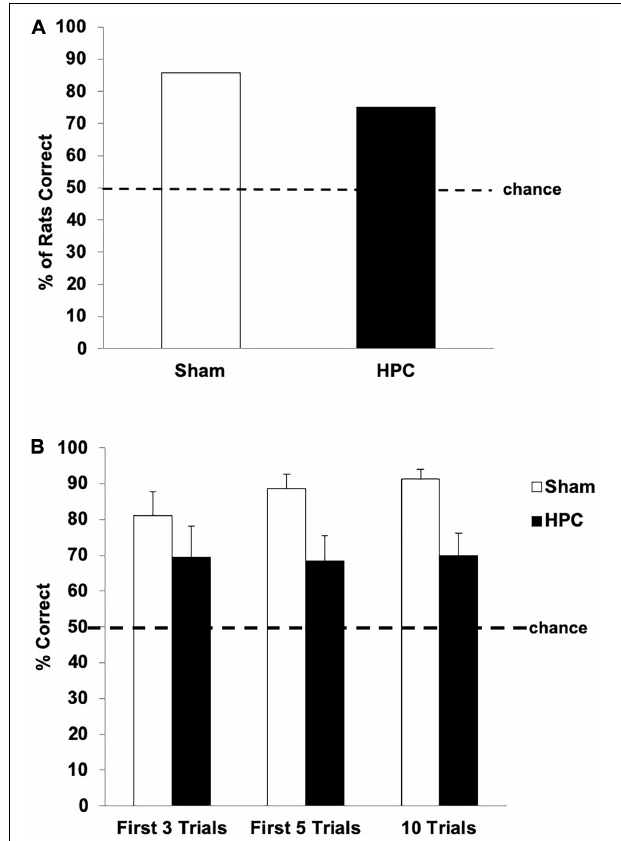
FIGURE 5 | Post-surgical retention performance of the Sham and HPC rats that received 230 overtraining trials following the visual discrimination criterion learning. (A) Percent of rats in each group choosing S+ on the first retention trial. Although both groups tended to show a preference in swimming to the S+, the bias was not statistically significant for either group ( p > 0.05). (B) Mean ( ± SEM) percent of correct trials on the first three trials, first five trials, and all 10 retention trials. Both Sham and HPC rats, regardless of the number of trials considered, showed a an S+ selection statically above chance (50%, ps < 0.05), suggesting that both groups remembered the discrimination. The HPC rats did selected the S+ fewer times than the Sham group across all 10 trials, but not earlier, suggesting that the control rats reacquired the discrimination and that the HPC did not show this relearning over the test. Overall, the 230 overlearning trials mitigated the amnesic effects of the HPC damage, but impaired fast reacquisition of the visual discrimination.